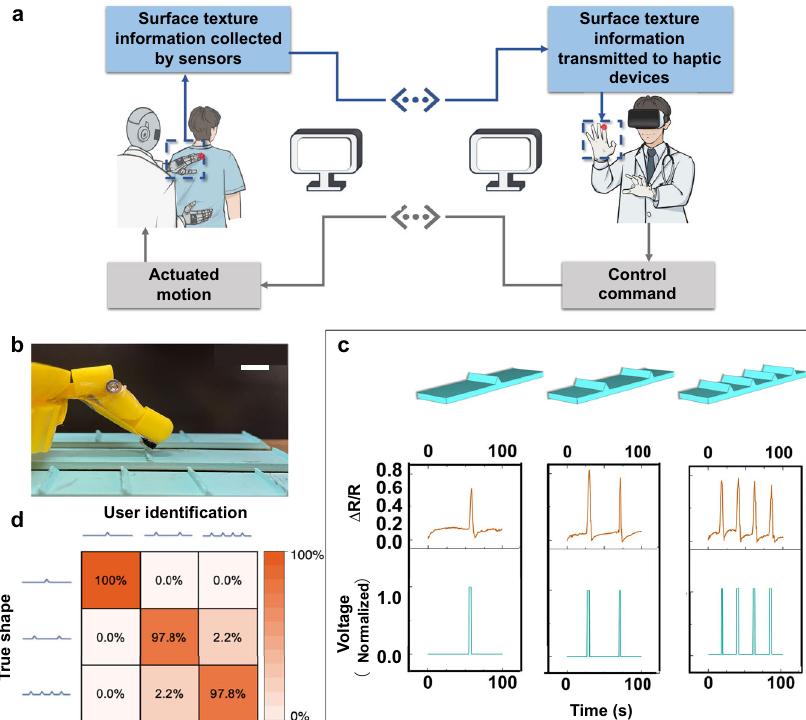
Fig. 7 Surface texture recognition. a Schematic illustrations of the closed-loop haptic feedback system for surface texture identi fi cation. b Picture of the pressure sensor attached to the robot fi nger (Scale bar: 10 mm). c Resistances changes detected by the pressure sensor and the corresponding voltage signals applied to the actuators when the robot fi nger slid over a 1-wedge surface, 2-wedge surface, and 4-wedge surface. d Confusion matrix showing the result of the surface texture recognition user